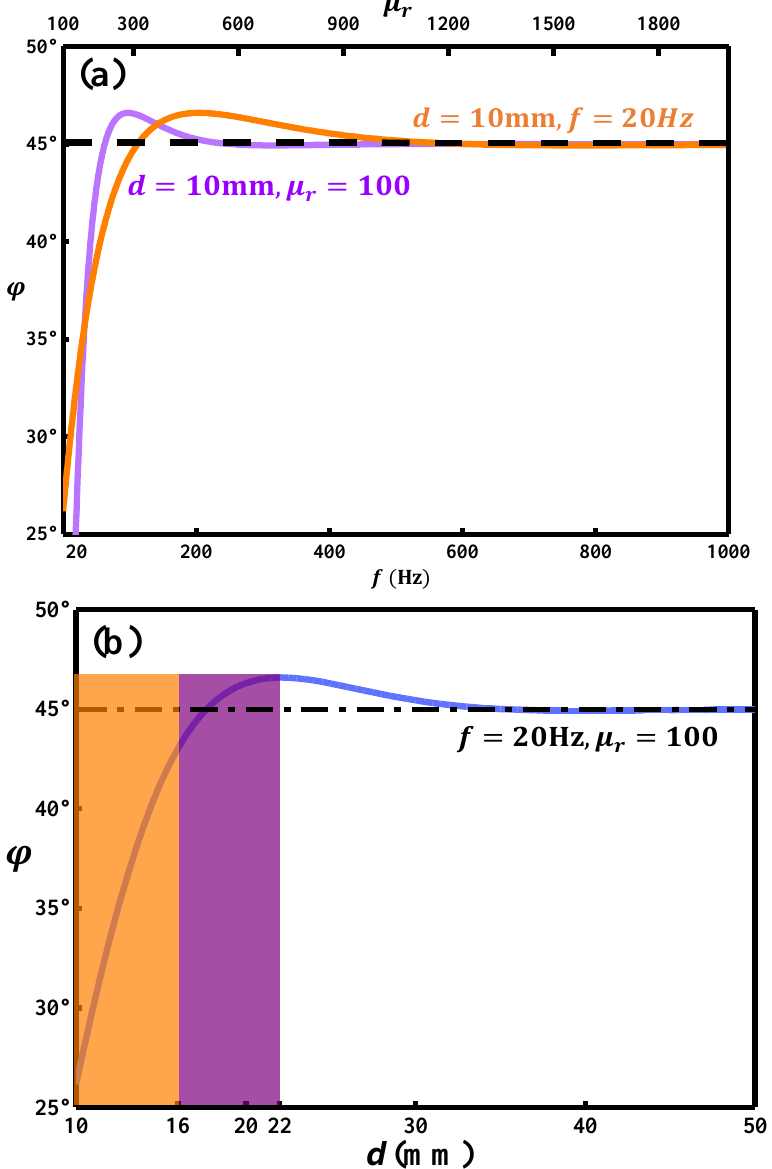
Figure 4. The phase ϕ with the change of ( a ) excitation frequency f and relative permeability µ r of 20# steel; ( b ) subsurface defect’s depth d .